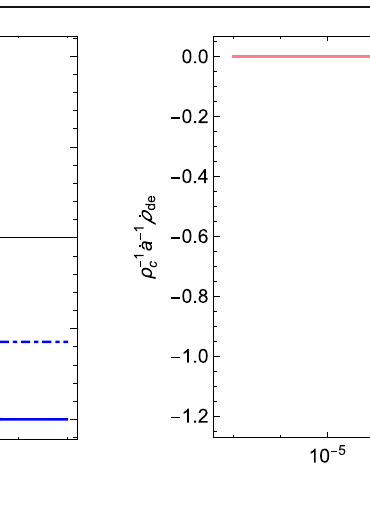
Fig. 6 An comparison of the calculated deceleration parameter q between the two models. The results of the standard (cid:2) CDM model are shown in solid curves, and those of the generalized Rastall theory are indicated by dash-dotted curves